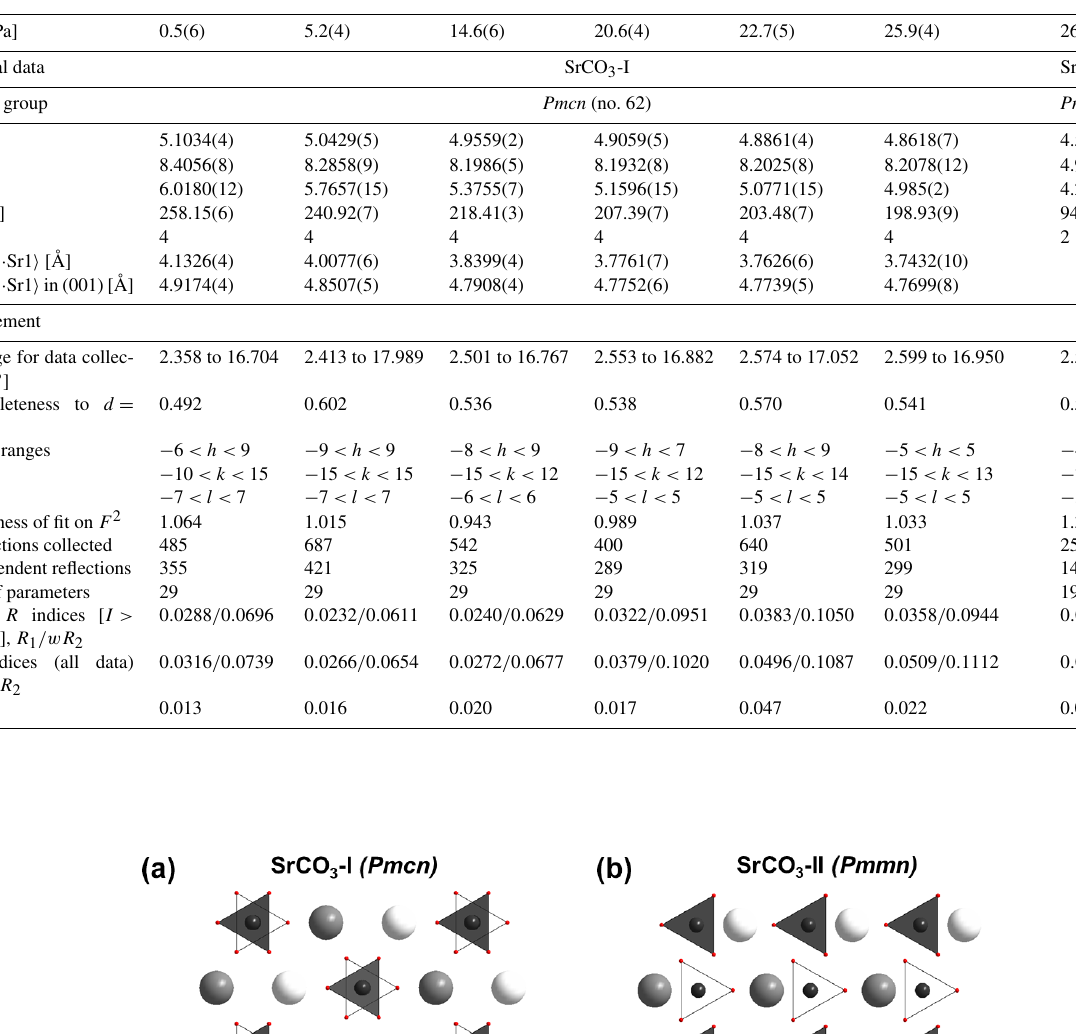
are additionally highlighted as white and 3 ions highlighted by grey rectangles shift by 3